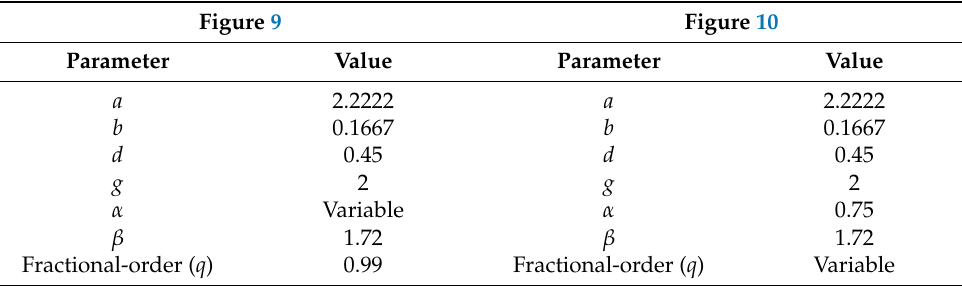
Figure 10. Bifurcation diagram, influence of the fractional-order derivative value ( q ) on the system state variable x ( t ). Table 2. The system (17) parameters and fractional-order derivative value ( q ) utilized in examination bifurcation diagrams (Figures 9 and